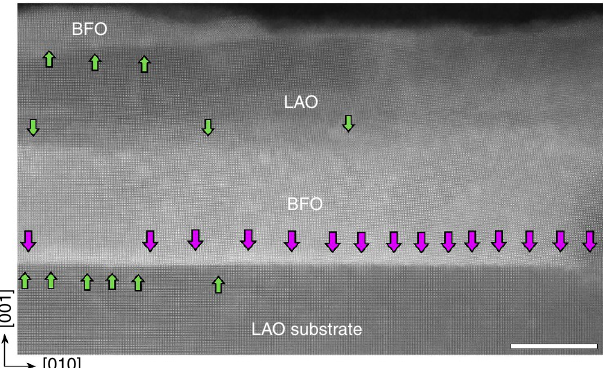
Figure 3 | Atomic resolved images of a BiFeO 3 /LaAlO 3 /BiFeO 3 / LaAlO 3 (001) multilayer island. Scale bar, 20nm. The first BiFeO 3 layer was deposited under a high deposition flux mode. Note that there are only a [011] type dislocations at the right side, while the a [010] type dislocations dominate at the left side, as marked with pink and green arrows, respectively. This dislocation configuration suggests that giant lattice rotation and resultant giant strain gradient may occur in the BiFeO 3 /LaAlO 3 /BiFeO 3 multilayer nanostructure.